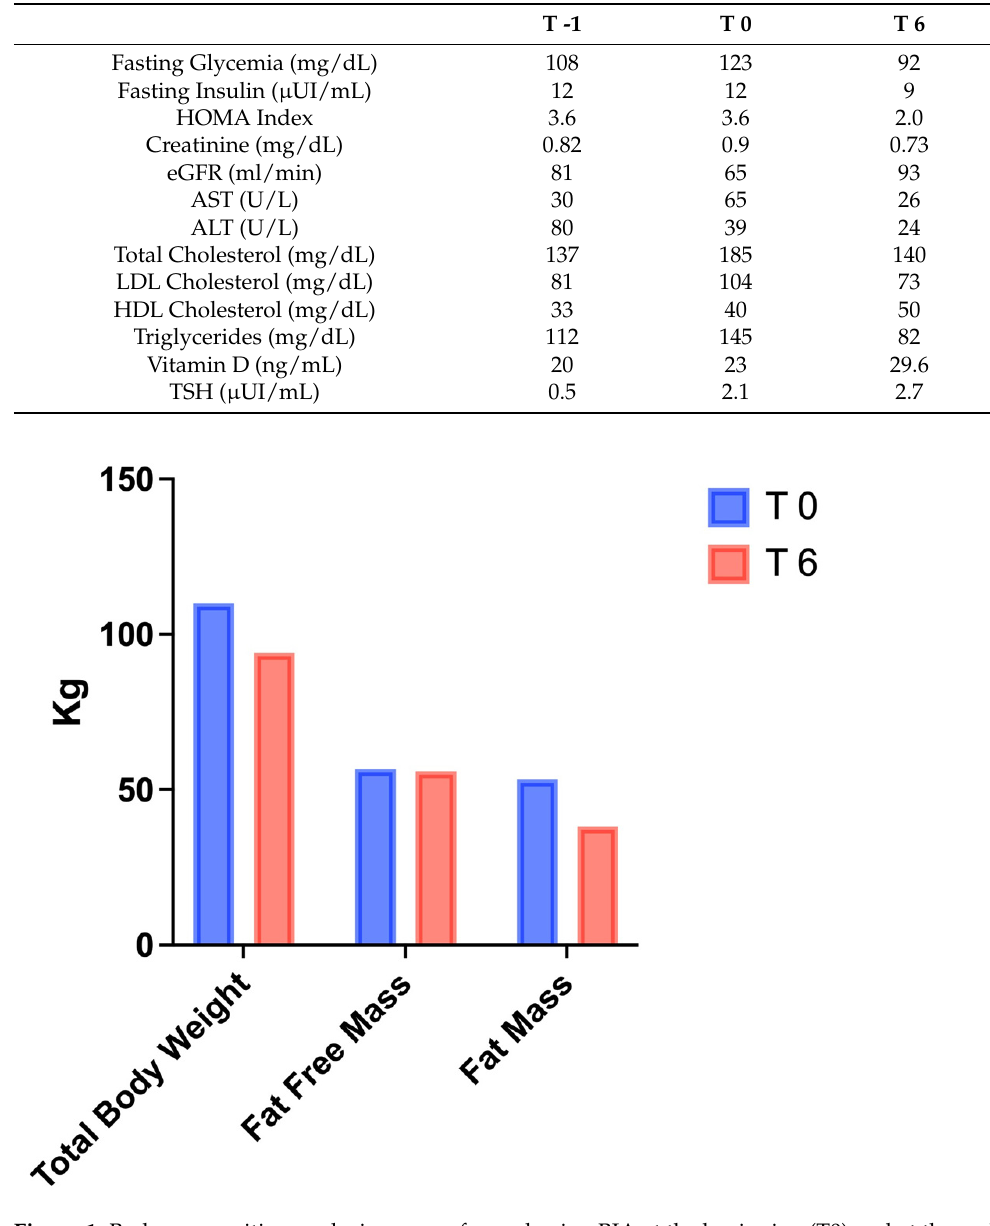
Figure 1. Body composition analysis was performed using BIA at the beginning (T0) and at the end (T6) of VLCKD+IT. Table 3. Characteristics of body composition and physical performance parameters at baseline (T0) and after 6 weeks (T6) of